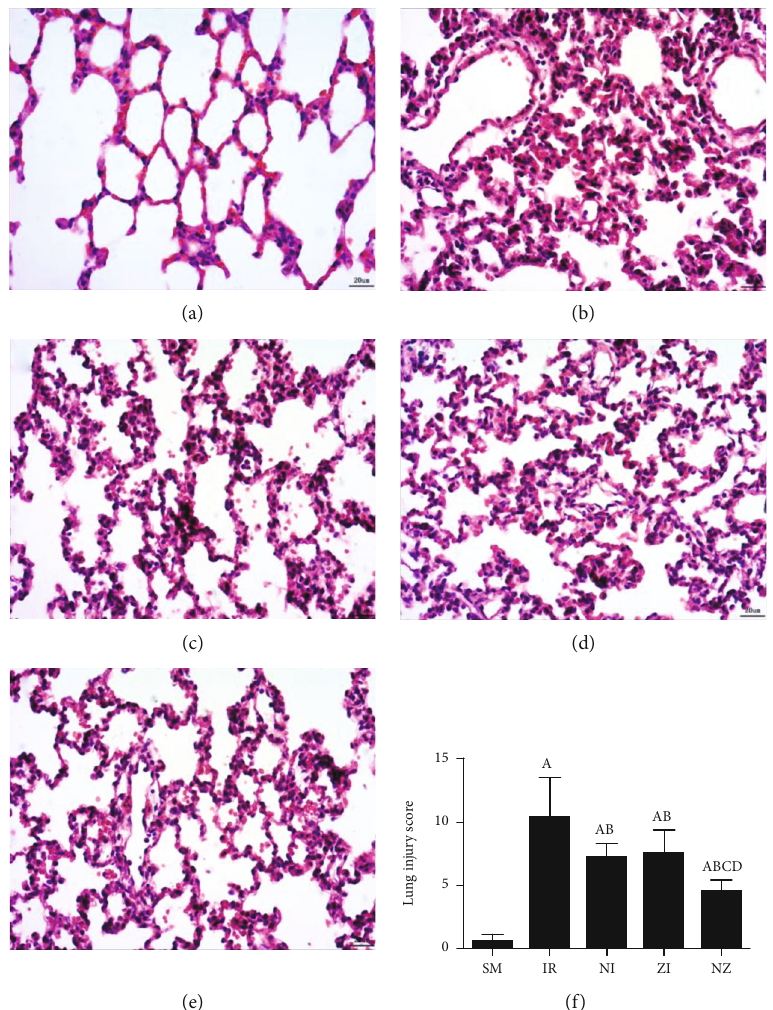
Figure 1: Microscopical changes in the lung tissue. The rats were randomly divided into fi ve groups. Brie fl y, the rats in the SM group received sham operation, while the left lung hilum was subjected to 1h of ischemia followed by reperfusion up to 3 h in the IR group. Intraperitoneal Nec-1 (1 mg/kg) and z-VAD-fmk (3 mg/kg) were administrated before lung ischemia in NI and ZI groups, respectively, and combined administration of Nec-1 and z-VAD-fmk was given in the NZ group. After 3h of reperfusion, the hematoxylin and eosin-stained lung sections were examined under light microscope, and the lung injury score was also evaluated. Figures 1(a) – 1(e) are representative photomicrographs (at × 400 magni fi cations) of SM, IR, NI, ZI, and NZ groups, respectively, and Figure 1(f) shows the lung injury score in groups. Data were presented as mean ± SD , n = 8 in each group. a P < 0 : 05 compared with the SM group, b P < 0 : 05 compared with the IR group, c P < 0 : 05 compared with the NI group, d P < 0 : 05 compared with the ZI